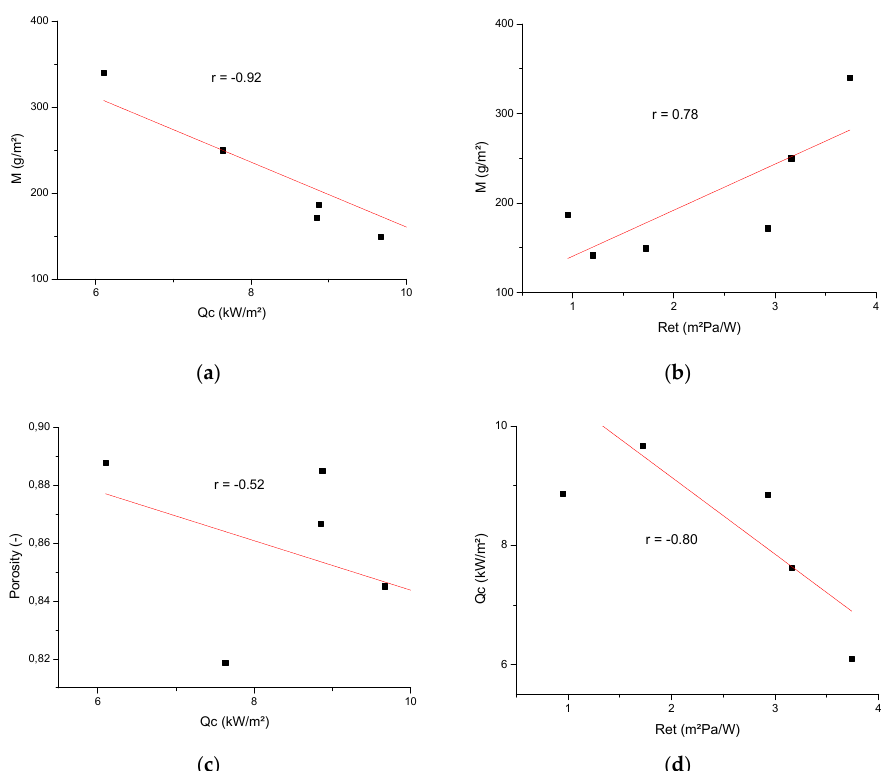
Figure 5. Plots with highly correlated parameters followed by linear fit and regression analysis: ( a ) Mass—Leaked heat flux density over sample to calorimeter; ( b ) Mass—Water vapor resistance; ( c ) Fabric volume porosity—Leaked heat flux density over sample to calorimeter; ( d ) Leaked heat flux density over sample to calorimeter—Water vapor Table 7. Parameters of the strength of the linear relationship between highly correlated properties.